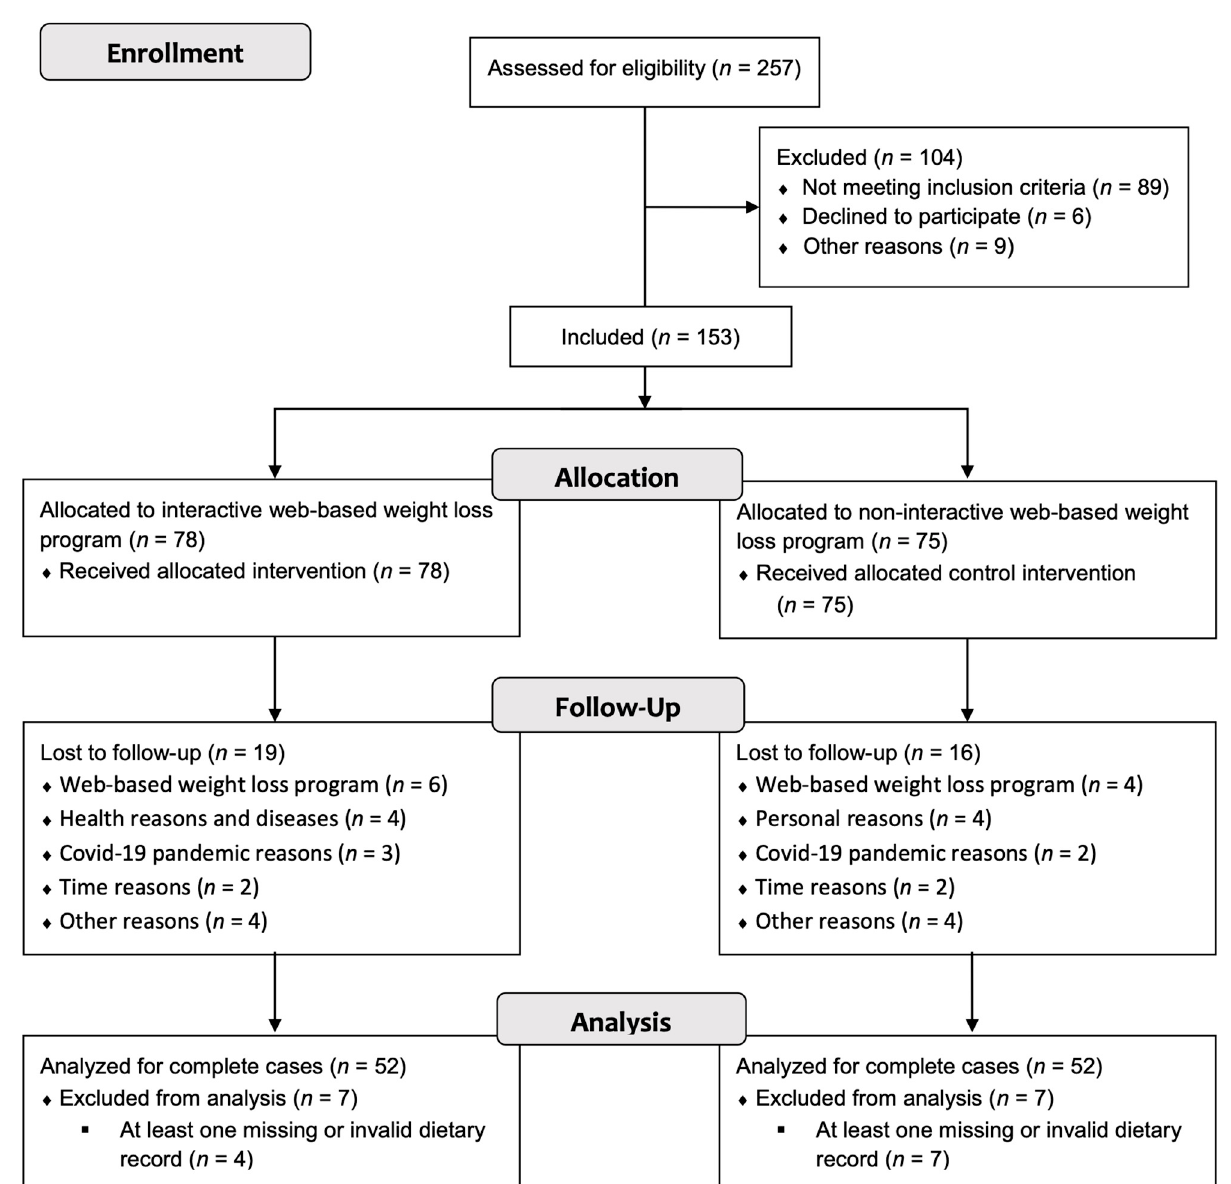
Figure 1. CONSORT flow chart depicting participant recruitment and drop-outs. Table 1. Baseline (t0) characteristics of the study participants 1 .